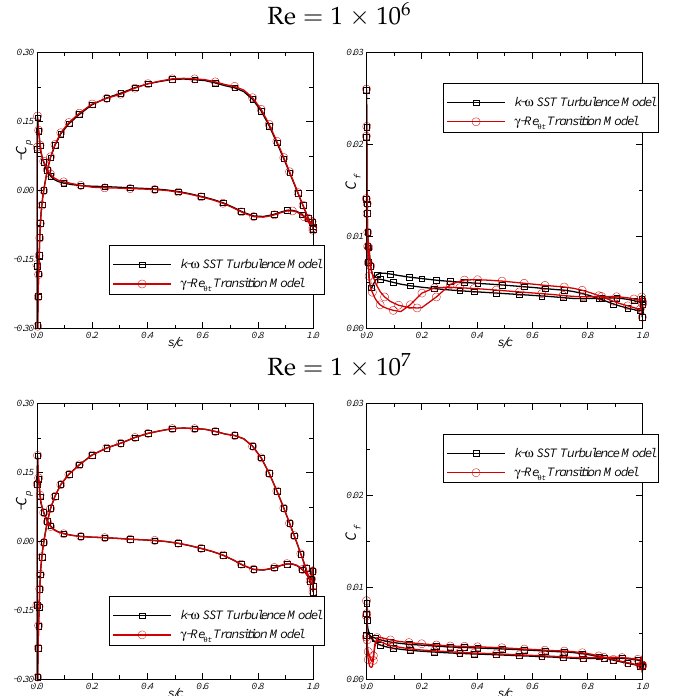
Figure 20. Blade pressure C p ( left ) and skin friction C f ( right ) distributions at r / R = 0.7 with the k − ω SST turbulence model and γ − ˜Re θ